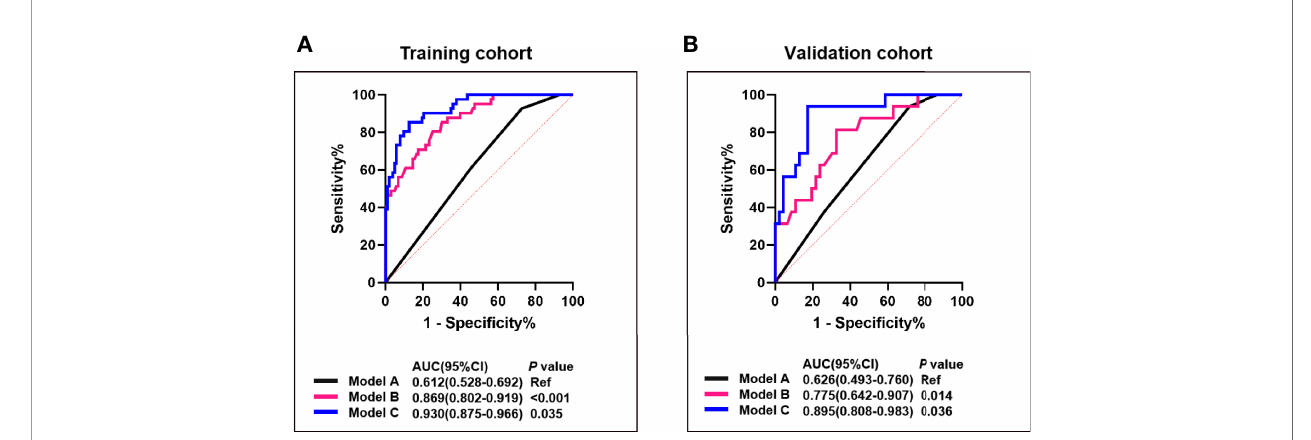
FIGURE 5 | Comparison of the predictive performance between model A, B and (C) ROC curves and AUCs for predicting pCR of model A (blue curve), model B (pink curve), and model C (black curve) in the training (A) and the validation cohort (B) . Model A, T stage + HER2 status; Model B, model A + RAD-score; Model C, model B + roundness.